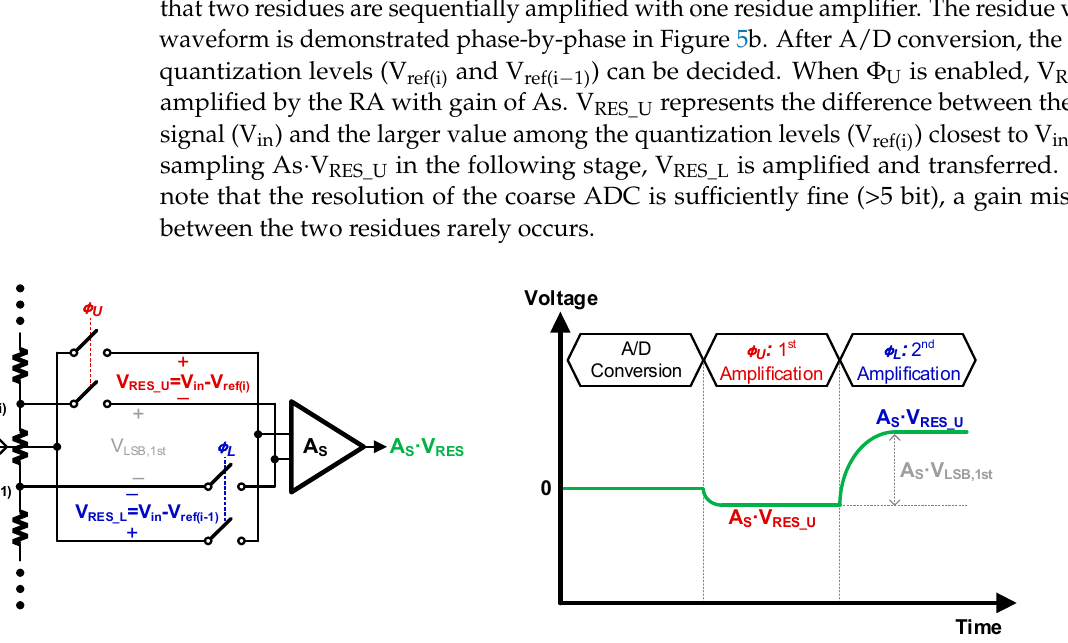
Figure 4. Block diagram of the proposed dual-residue pipelined-SAR ADC.